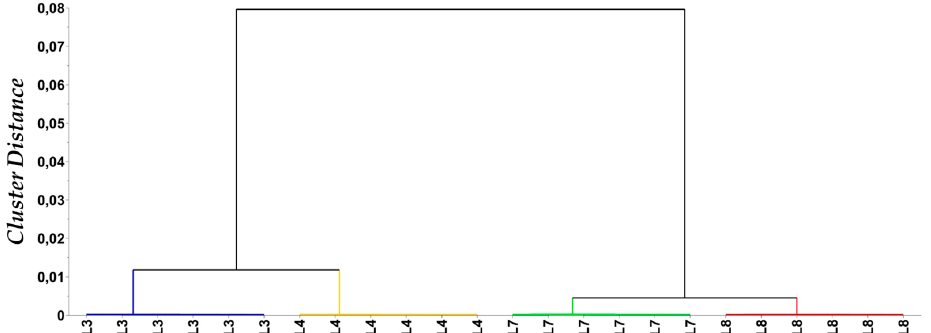
Figure 4. Hierarchical tree diagram of the GC/EI/MS metabolite profiles of Lupinus albus cultivars using the Ward’s method.